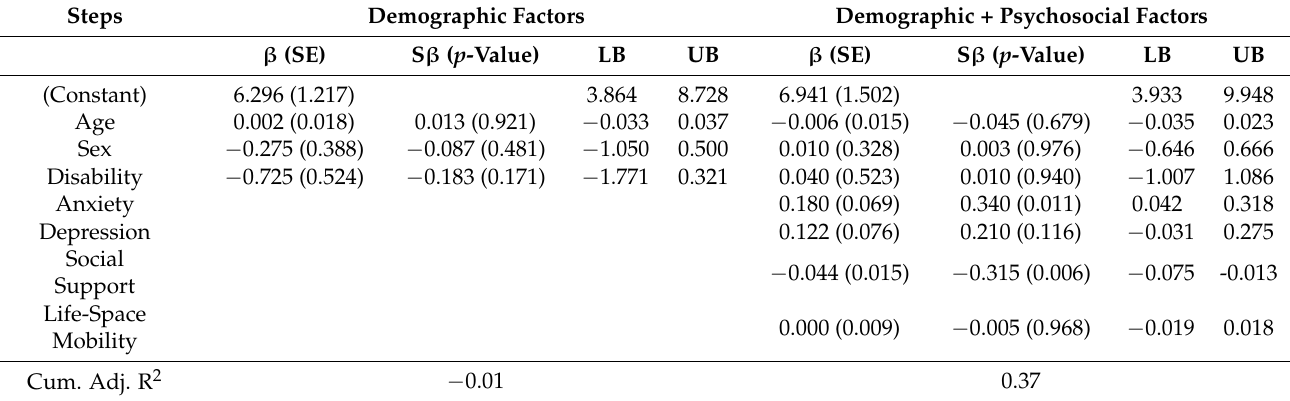
Table 2. Hierarchical linear regression results with depression, anxiety, social support, and space mobility as the independent and loneliness as the dependent variables while controlling for age, sex, and disability